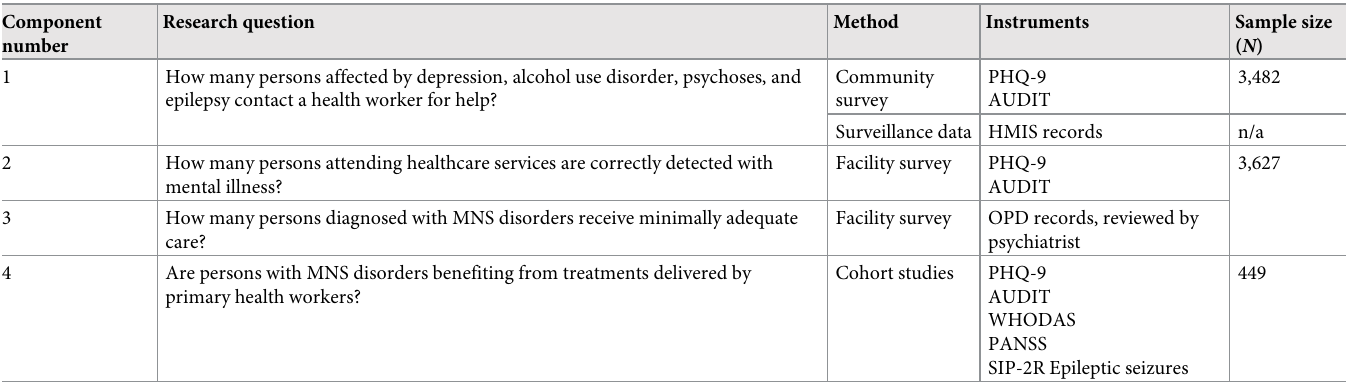
Table 2. Overview of study